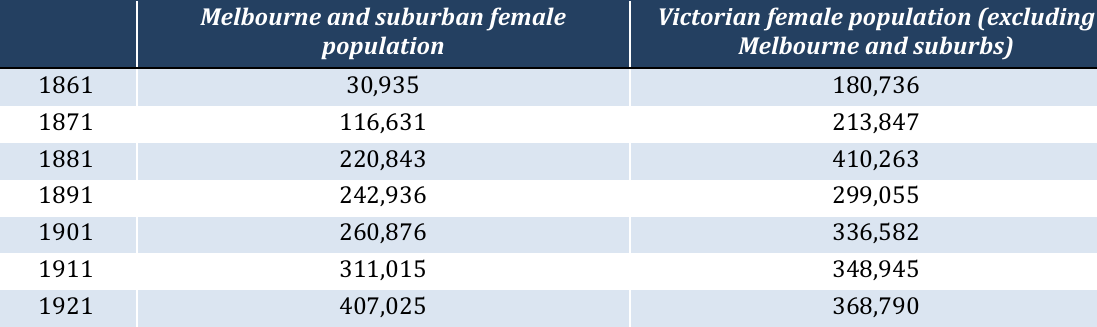
Table 1: Urban and rural female population Melbourne and suburban female Victorian female population (excluding population Melbourne and